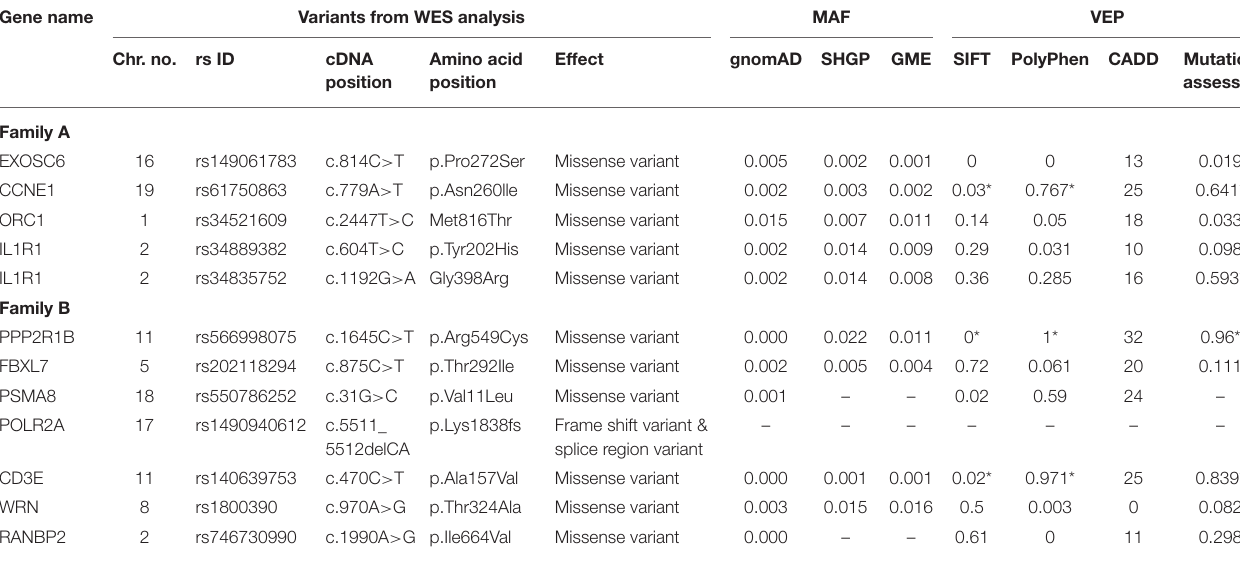
TABLE 3 | Rare coding variants of the hub genes from WES–GWAS protein networks of families A and